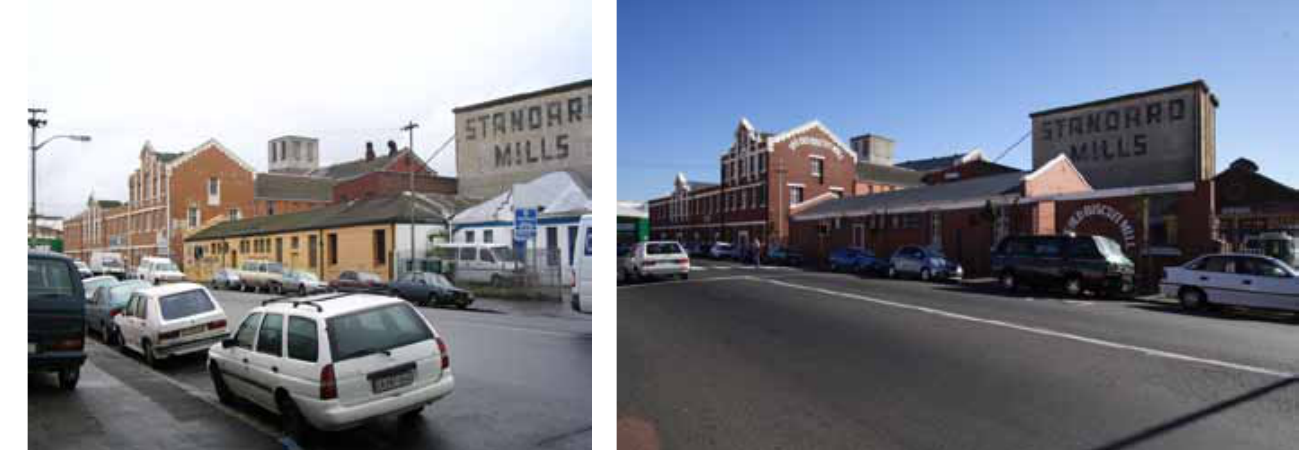
Figure 3: The Old Biscuit Mill before its renovation (2004) and today